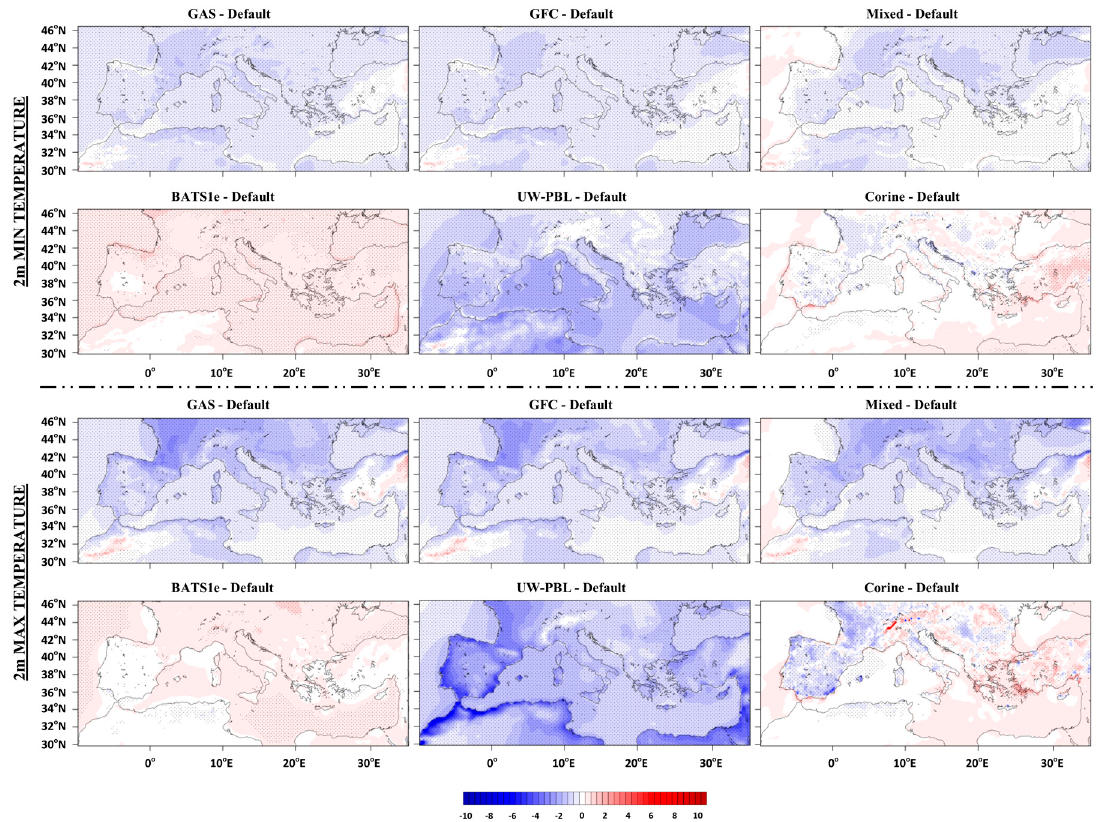
Figure 10. Differences in near surface (2 m) min and max temperature from the default simulation for the performed simulations during summer. The statistical significance of the differences in the maps is represented by the dotted